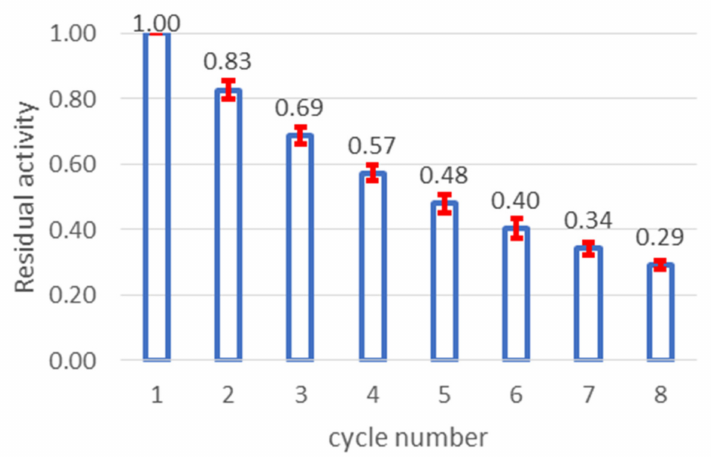
Figure 6. Residual activity evolution for several consecutive hydrolysis cycles. Conditions: 20 g/L (58.5 mM) cellobiose in 100 mM citrate buffer pH 5.0 under orbital shaking at 400 rpm and 50 ◦